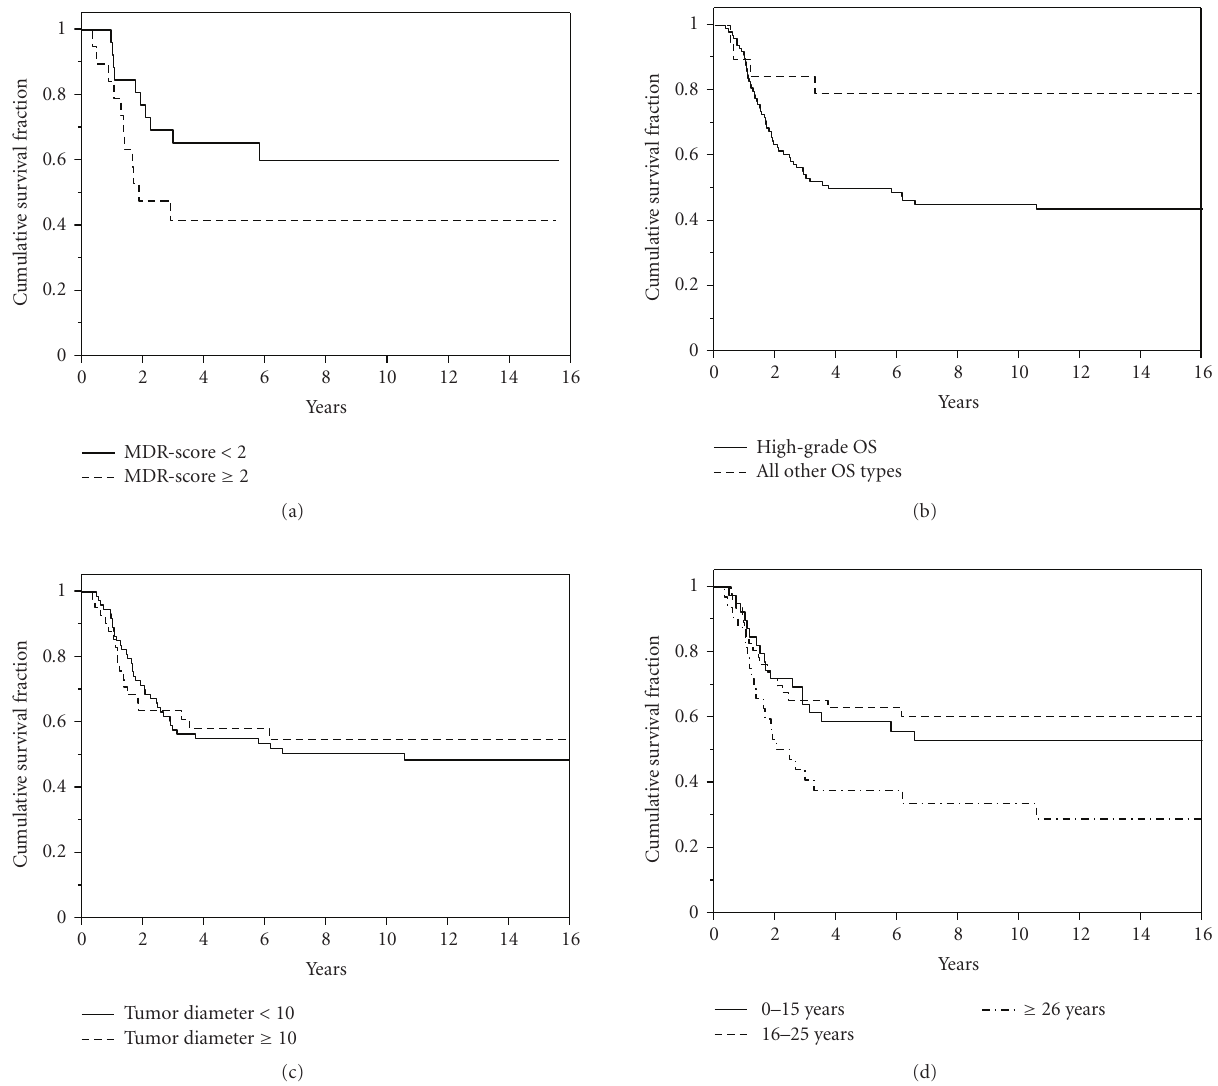
Figure 4: Kaplan-Meier plots of survival in patients with osteosarcoma regarding (a) multiple drug resistance score ( P = . 12; log rank test), (b) histological type of osteosarcoma ( P = . 02), (c) tumor diameter ( P = . 11), (d) and patient age at diagnosis ( P = . 03).